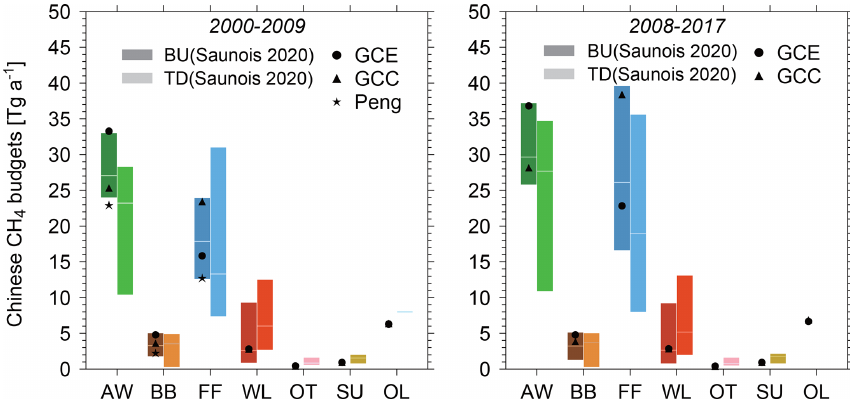
Figure 4. Similar to Fig. 3 but for CH 4 sources and sinks over China averaged for the 2000–2009 and 2008–2017 periods. The bar charts show previous Chinese bottom-up (dark-colored bars on the left) and top-down (light-colored bars on the right) estimates as summarized by Saunois et al. (2020) and Kirschke et al. (2013) and are compared with model results in the GCE (black circles) and GCC (black triangles) simulations. The bottom-up estimates of 2000–2009 mean Chinese CH 4 emissions by Peng et al. (2016) are also shown as black stars. Values presented in the figure are summarized in Table